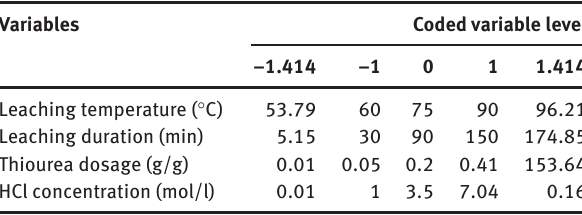
Table 2: Range of variables utilized in the experimental design.